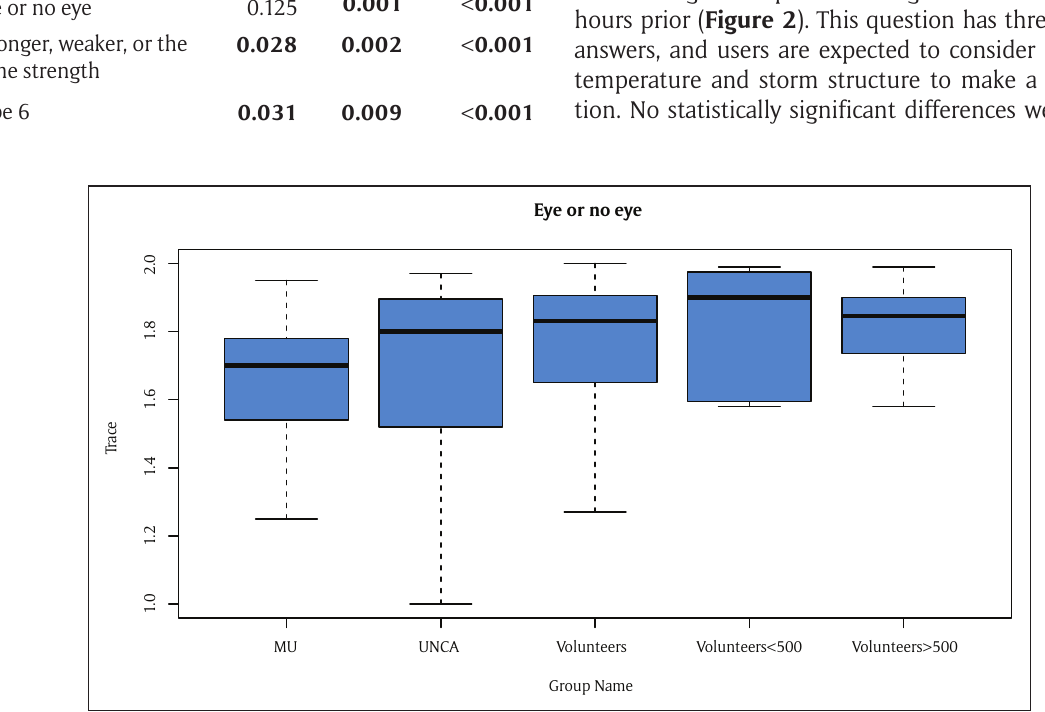
Figure 3: Boxplot of the results for eye or no eye. There are two choices, so skill is bound between 0 and 2, where 2 would indicate complete consistency with the bias-adjusted voting majority classification on all occasions. A trace value of 1 would represent completely random selections by the users and thus a complete lack of skill for this task. Boxes indicate interquartile ranges and whiskers denote 5–95% ranges. The median trace value in each population is indicated by the horizontal bar in the interquartile box. Both the full volunteer sample and the subsets of medium and high intensity users are